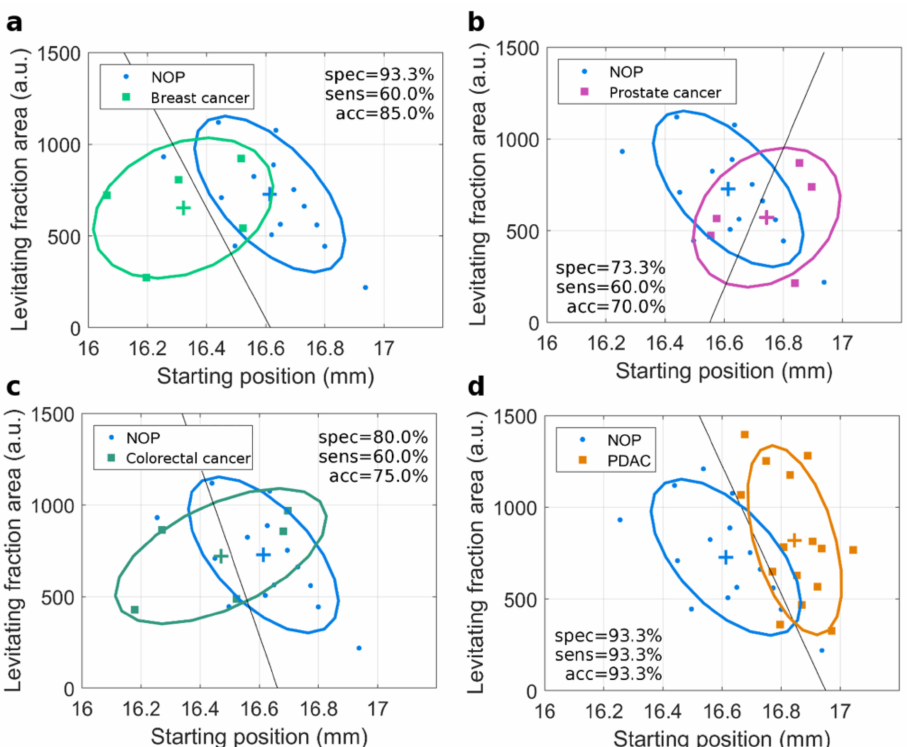
Figure 3. MagLev fingerprints for cancer. Scatterplots of detected MagLev fingerprints for ( a ) breast cancer, ( b ) prostate cancer, ( c ) colon cancer, and ( d ) PDAC. NOP samples are superimposed as references in all the panels. Mean values are reported as crosses, multivariate distributions are depicted by ellipses. Outputs from linear discriminant analysis (LDA) are indicated by solid lines. Test specificity, sensitivity, and global accuracy are listed in each panel. Specificity = number of correctly classified NOP/total number of NOP; sensitivity = number of correctly classified cancer patients/total number of cancer patients; accuracy = number of correctly classified subjects/total number of